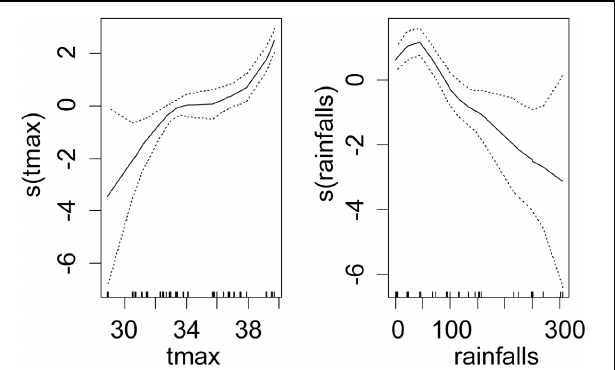
FIGURE 3 | Shape and amplitude of the relationships between tsetse infection rate with T. congolense and environmental variables. The values were estimated by a logistic regression model of cubic spline functions of environmental variables (tmax: maximum monthly averages of air temperature in ◦ C measured in meteorological stations, rainfalls: total monthly rainfalls in mm). For each environmental variable y, s(y) represents the fit of the regression model and the uncertainty lines present the standard